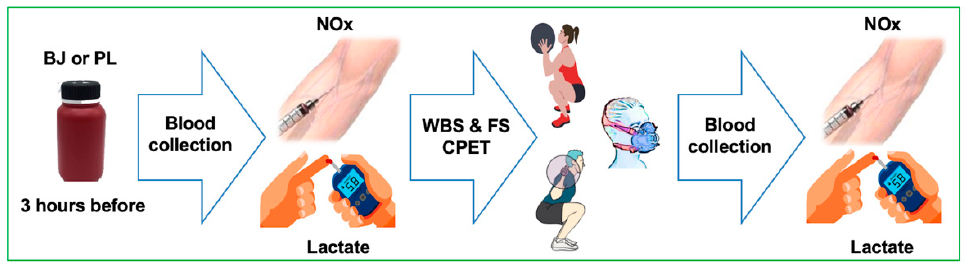
Figure 1. Procedures during the resistance exercise test after beetroot juice (BJ) intake and the placebo (PL) condition of the third and fourth session/BJ or PL randomized, double-blind, crossover design. Abbreviations used: BJ: beetroot juice; CPET: cardiopulmonary exercise test; FS: full squat; NOx: nitrate plus nitrite; PL: placebo; WBS: wall ball shots.